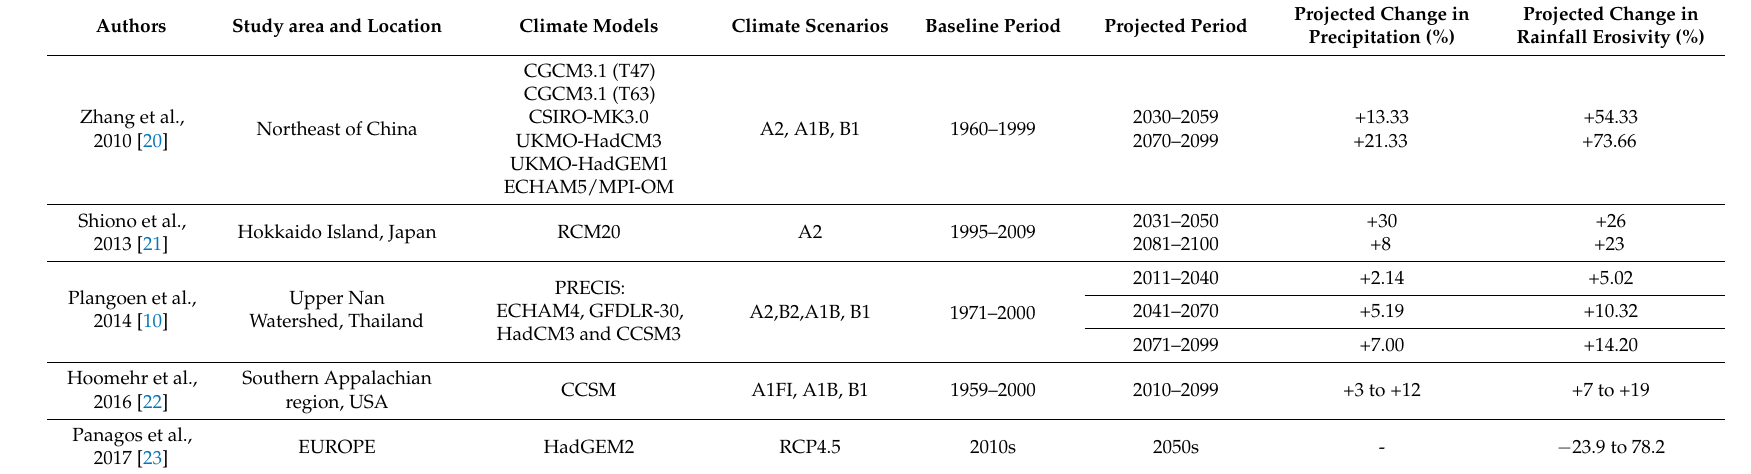
Table 1. Previous studies about impacts of climate change on rainfall erosivity.